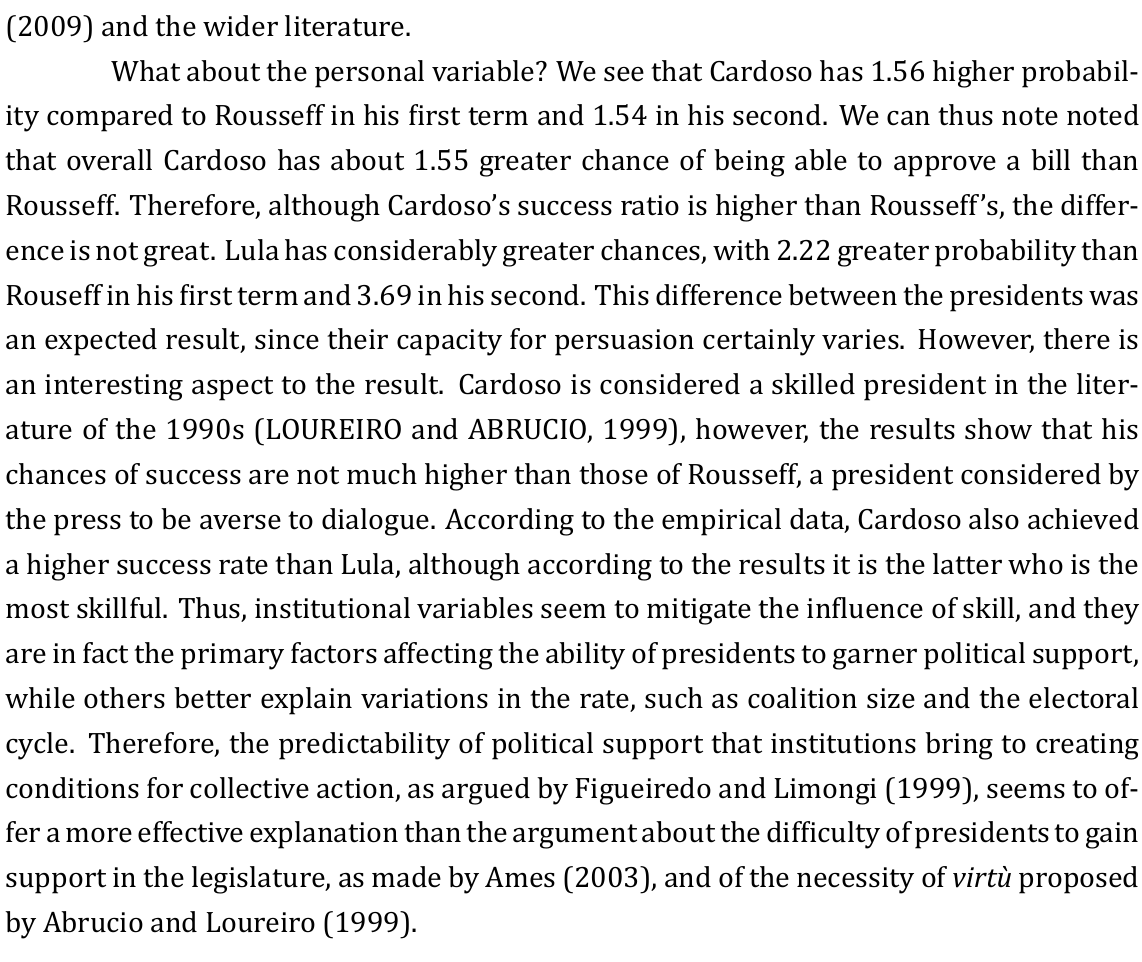
Figure 3: Reasons for the chances of legislative success of the executive in Brazil: 1995-2014